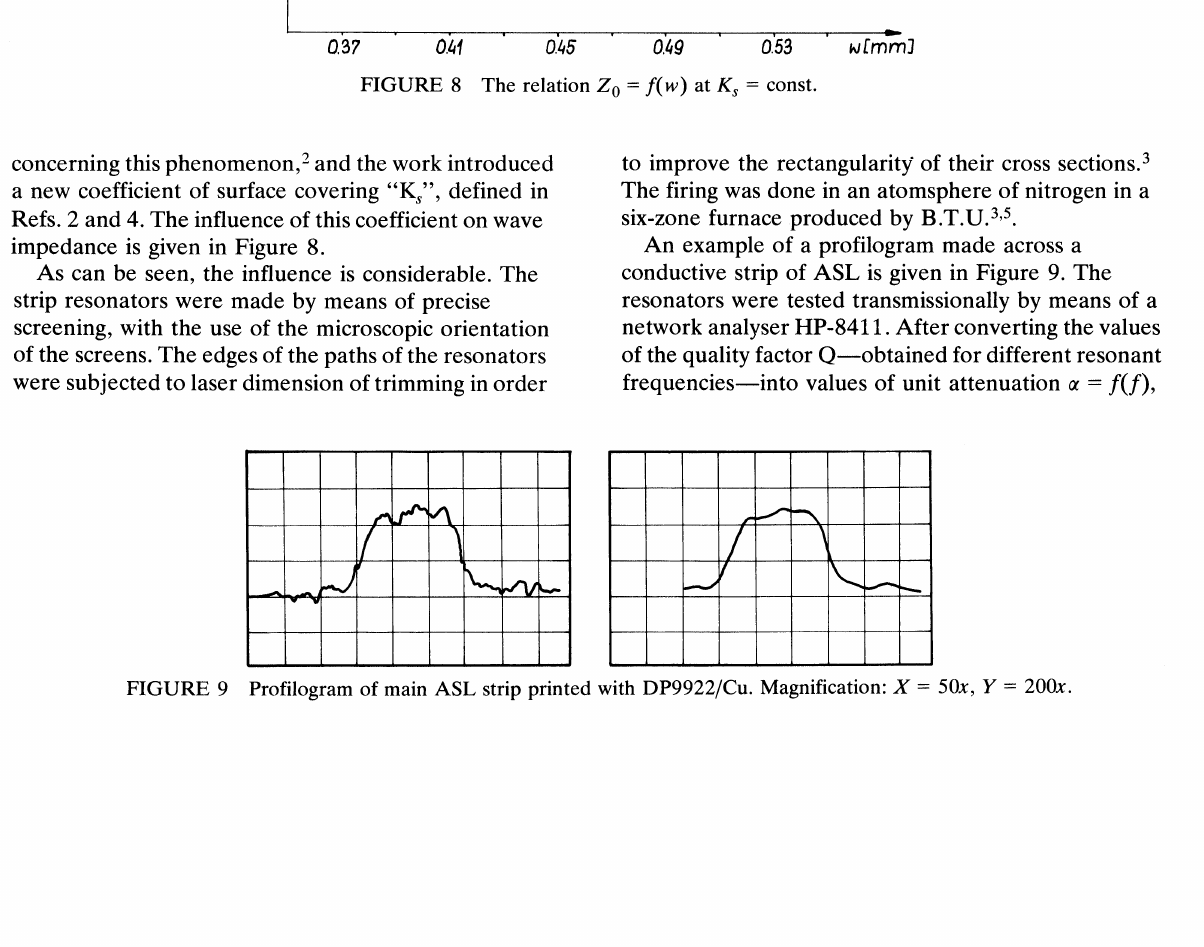
o.s o, o.5 f(w) at K const. 0